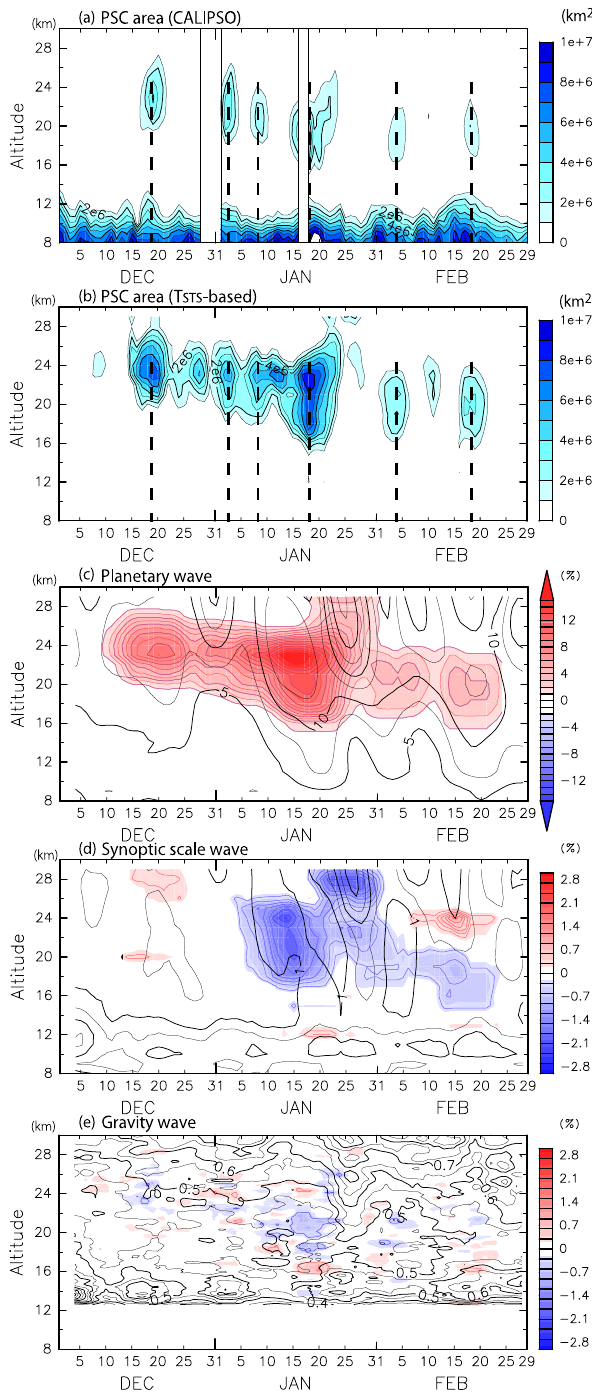
Fig. 15. (a) and (b) The same as Fig. 8 but for the latitude range of 55 ◦ N–85 ◦ N in the 2007/2008 winter. (c–e) The same as Fig. 10 but for the the latitude range of 55 ◦ N–85 ◦ N in the 2007/2008 winter. Contour intervals are 2.5K for (a) , 0.5K for (b) and 0.05K for (c)